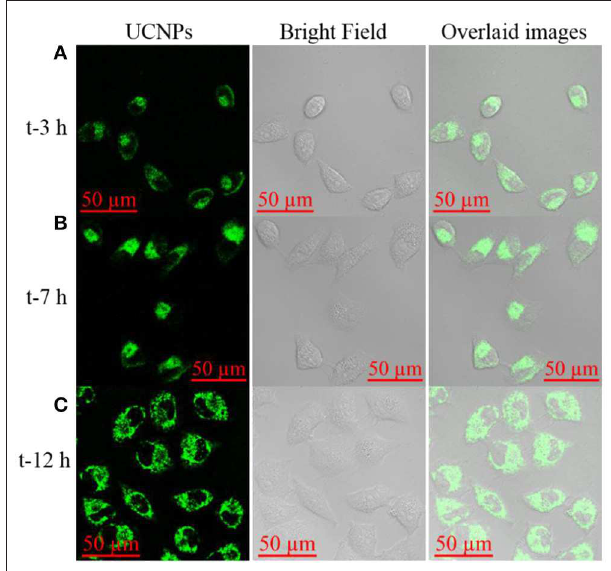
FIGURE 4 | Upconversion luminescence imaging of MCF-7 cells treated with 70 µ g/mL of the prepared nanoprobe for (A) 3h, (B) 7h, and (C) 12h. Green channel was collected the 515–575nm under the excitation of NIR laser to obtain the UCNPs information; Bright field was used to obtain the cell information.